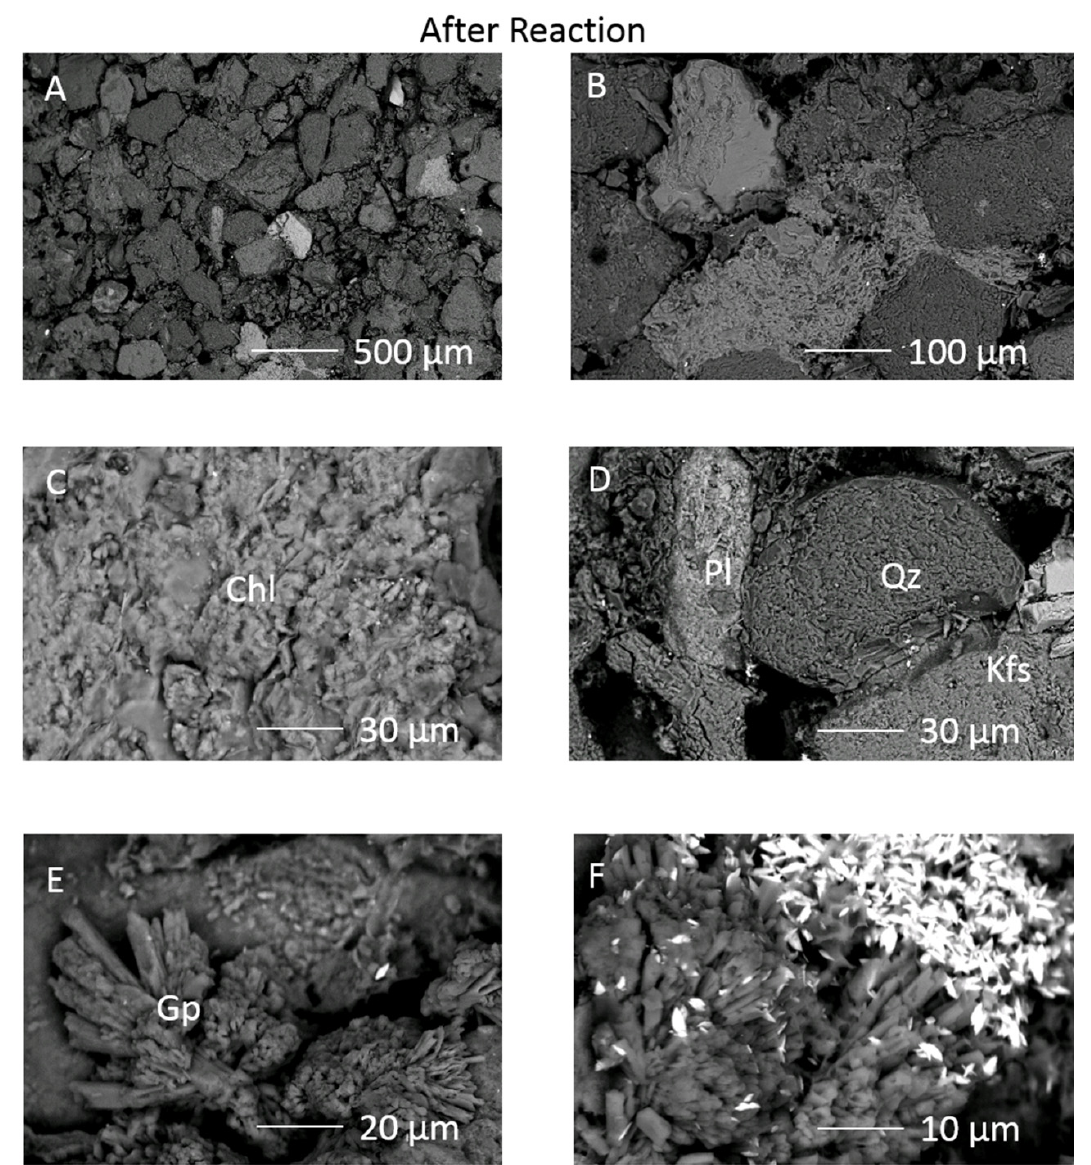
Figure 3. SEM images of the exposed surface of the 1053 m calcite cemented cap ‐ rock sub ‐ sample after reaction ( A ) surface view of the framework grains with calcite cement dissolved; ( B ) Quartz and silicate framework grains remaining with calcite cement dissolved; ( C ) Chlorite surface with alteration; ( D ) quartz, plagioclase and K ‐ feldspar grains remain with open porosity formed; ( E ) gypsum growing out of pore space; ( F ) precipitated gypsum and bright barite crystals. Chl = chlorite, Pl = plagioclase, Qz = quartz, Kfs = K ‐ feldspar, Gp = gypsum/Ca ‐ sulphate.